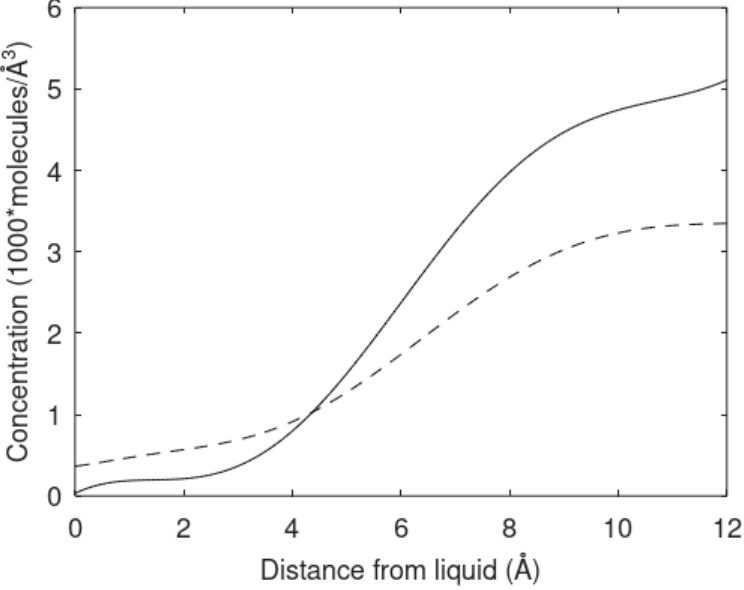
Figure 10. Concentration profiles for CH4 (solid) and CO2 (dash) as function of distance from liquid side of the interface.